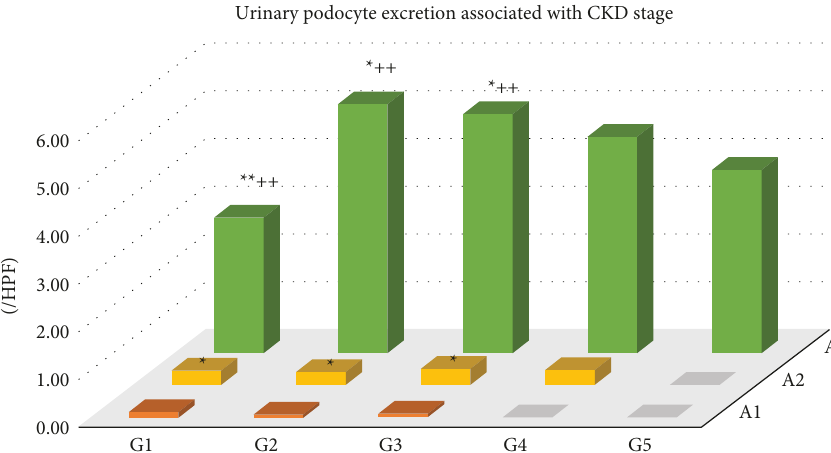
Figure 6: Urinary podocyte excretion associated with CKD stages with G1 to G5 as well as with A1 to A3. ∗ p < 0 . 05 and ∗∗ p < 0 . 01 vs. A1, ++ p < 0 . 01 vs.